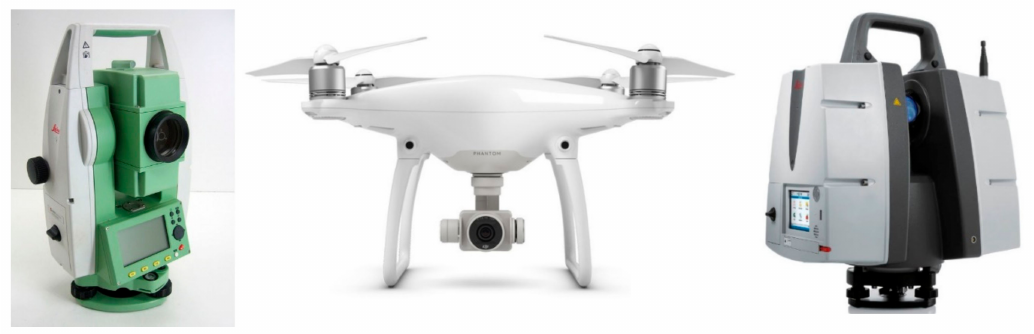
Figure 6. Leica TS02 total station (left), DJI Phantom 4 Pro (middle), and 3D scanner Leica P40